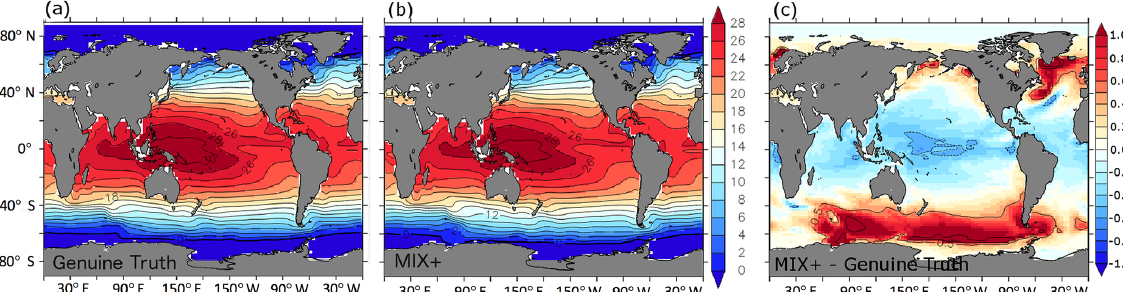
Figure 1. Simulated sea surface temperature in degrees Celsius for the historical simulations (see Sect. 2.2.2). Panels (a) and (b) refer to results from the model configurations Genuine Truth and MIX+, respectively. MIX+ features an increased vertical background diffusivity relative to the Genuine Truth (see also Table 1). Panel (c) shows the difference between MIX+ and the Genuine Truth.